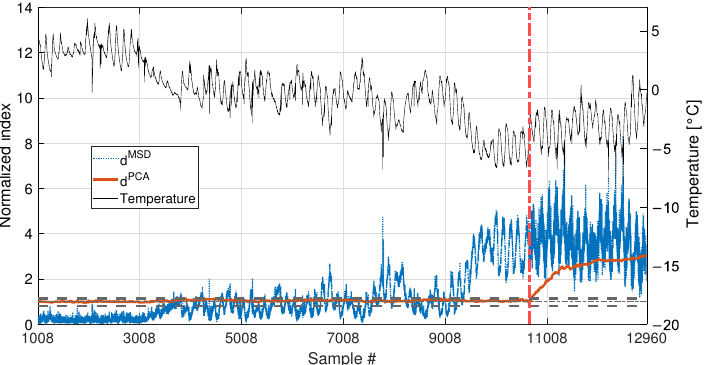
Figure 21. Comparison between d MSD (blue dotted line) and d PCA (red solid line), with b = 1008, con- sidering a real temperature trend (black thin line) and damage (30% reduction of Young’s